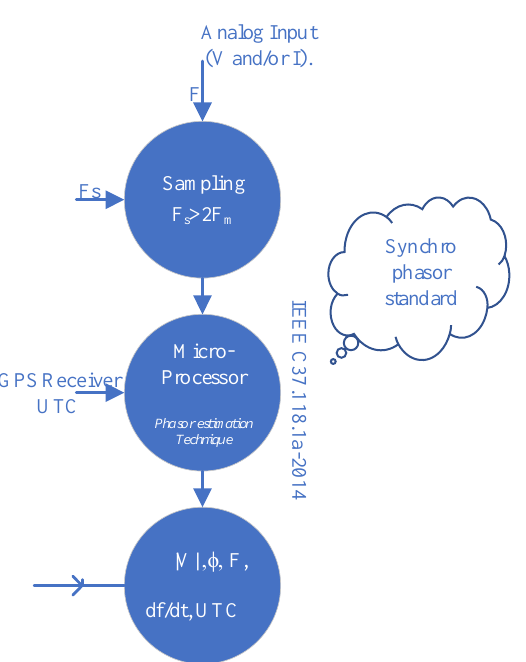
Figure 1. Conventional phasor measurement unit (PMU).